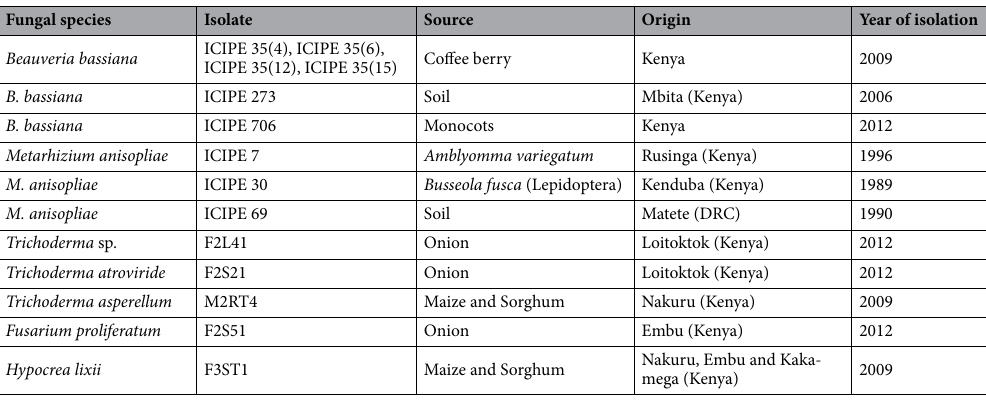
Table 1. List of fungal isolates used in this